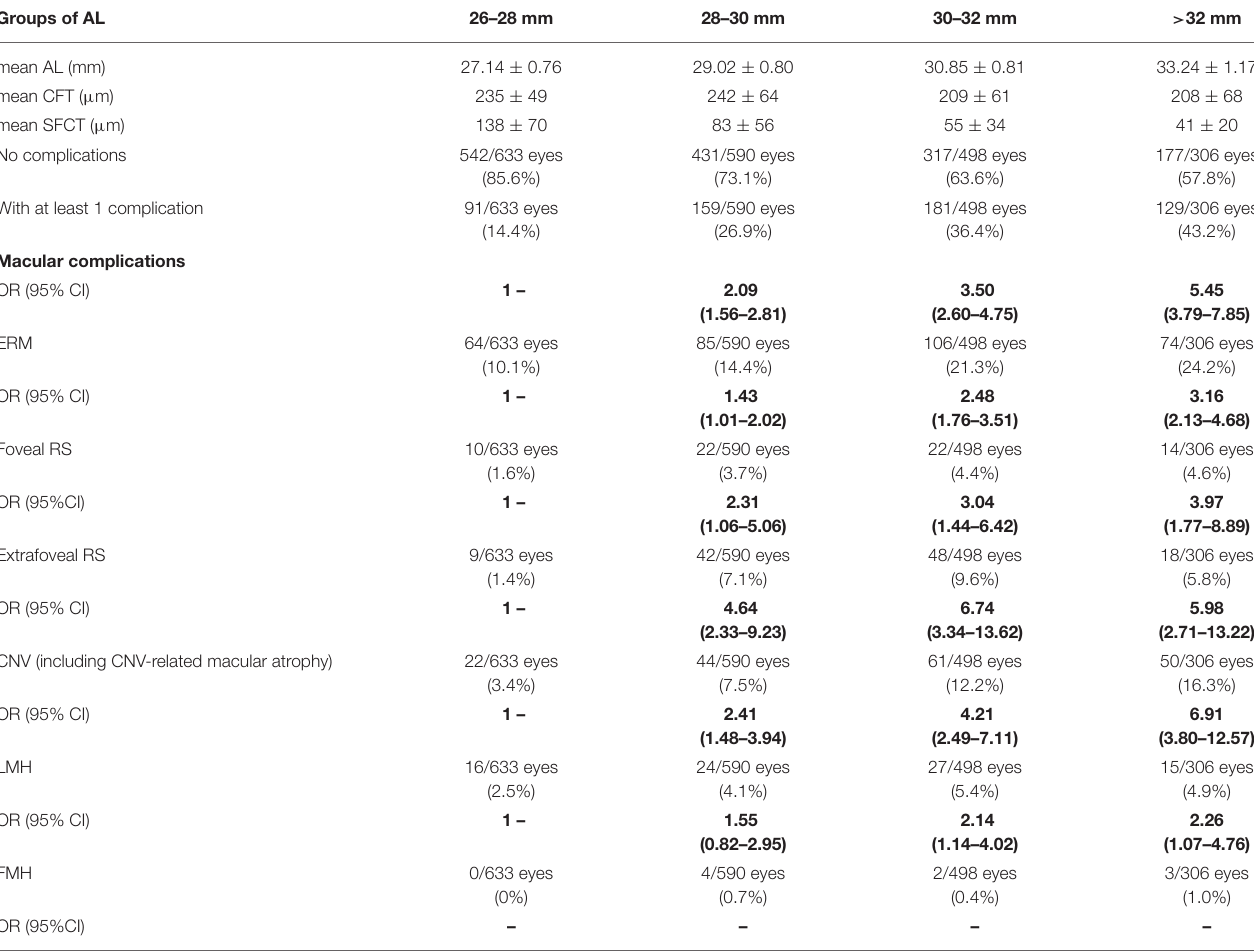
TABLE 2 | Incidence of macular complications in highly myopic cataract eyes according to axial length. Groups of